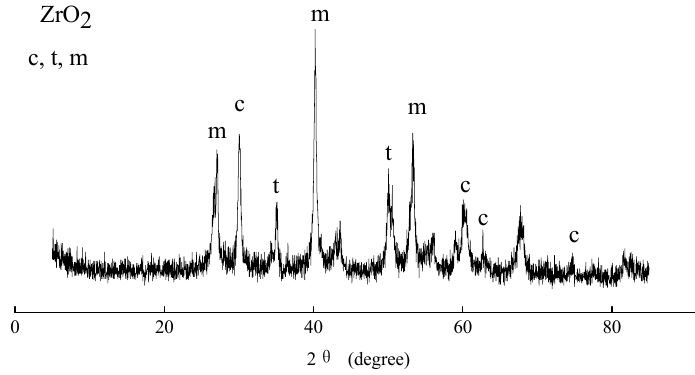
Figure 11. The phase compositions of the ZrO 2 ceramic membranes.